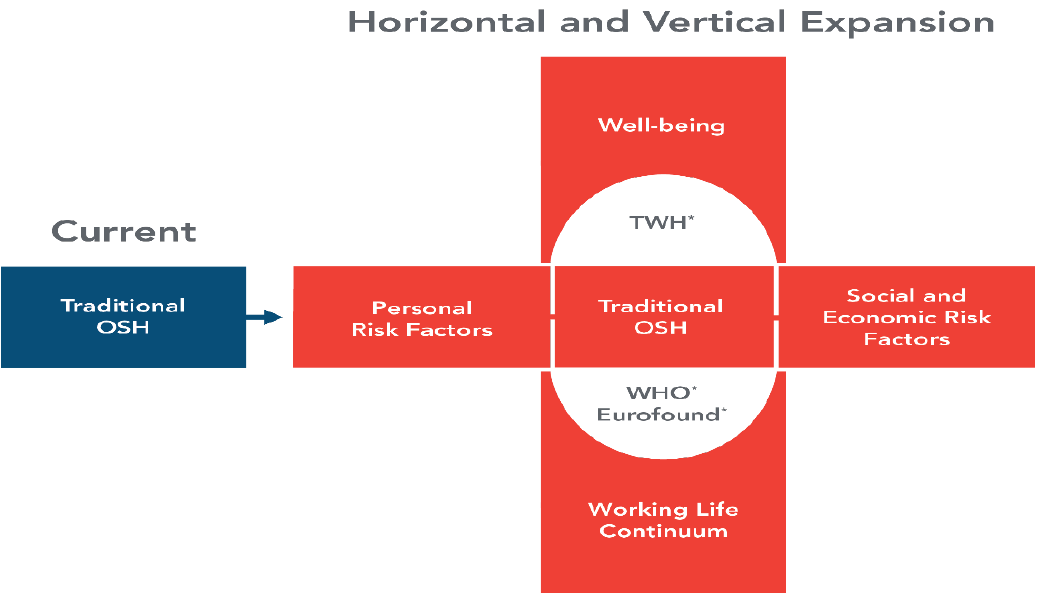
Figure 1. An expanded focus for occupational safety and health [11]. * Horizontal and vertical expansion build on the work of WHO [22], Eurofound [23], and Total Worker Health (TWH) [24,25].